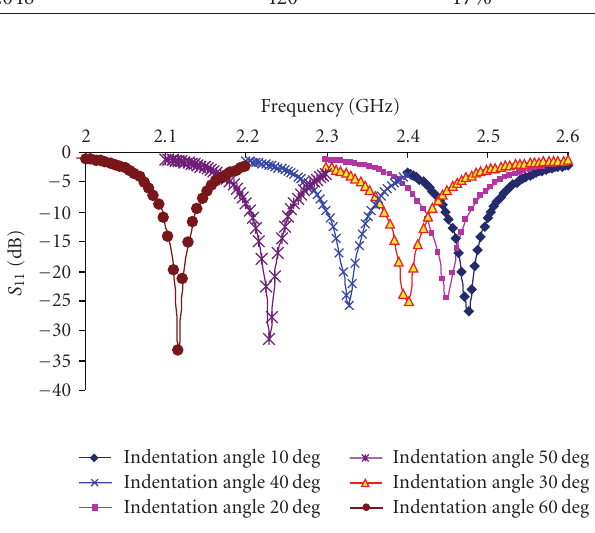
Figure 4: S 11 characteristics of 1st iteration Koch fractal boundary microstrip antennas with di ff erent indentation angles.